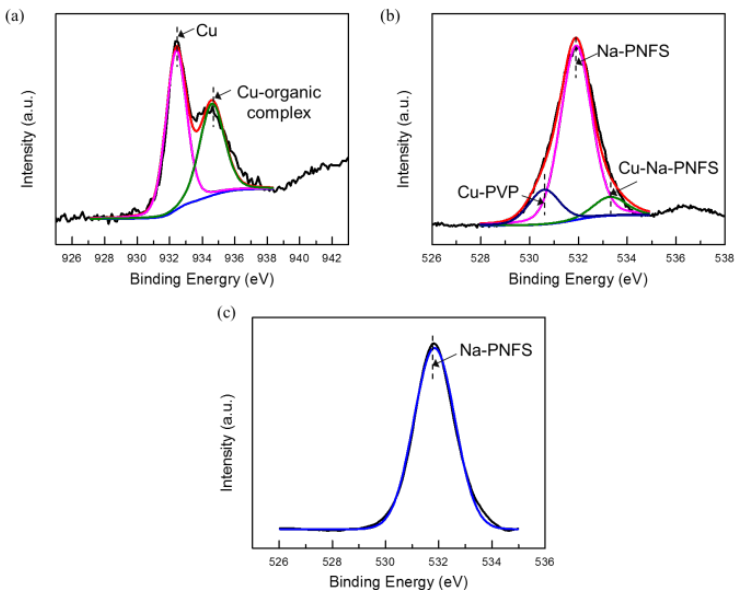
Figure 7. XPS spectra of ( a ) Cu 2p3/2 (raw line in red, with corresponding fitted two peaks, Cu in pink line, Cu-organic complex in green line); ( b ) O1s of Cu@organic (raw line in red, with corresponding fitted three peaks, Cu-PVP in blue line, Na-PNFs in pink line, Cu- Na-PNFs in green line); ( c ) O1s of Na-PNFS.